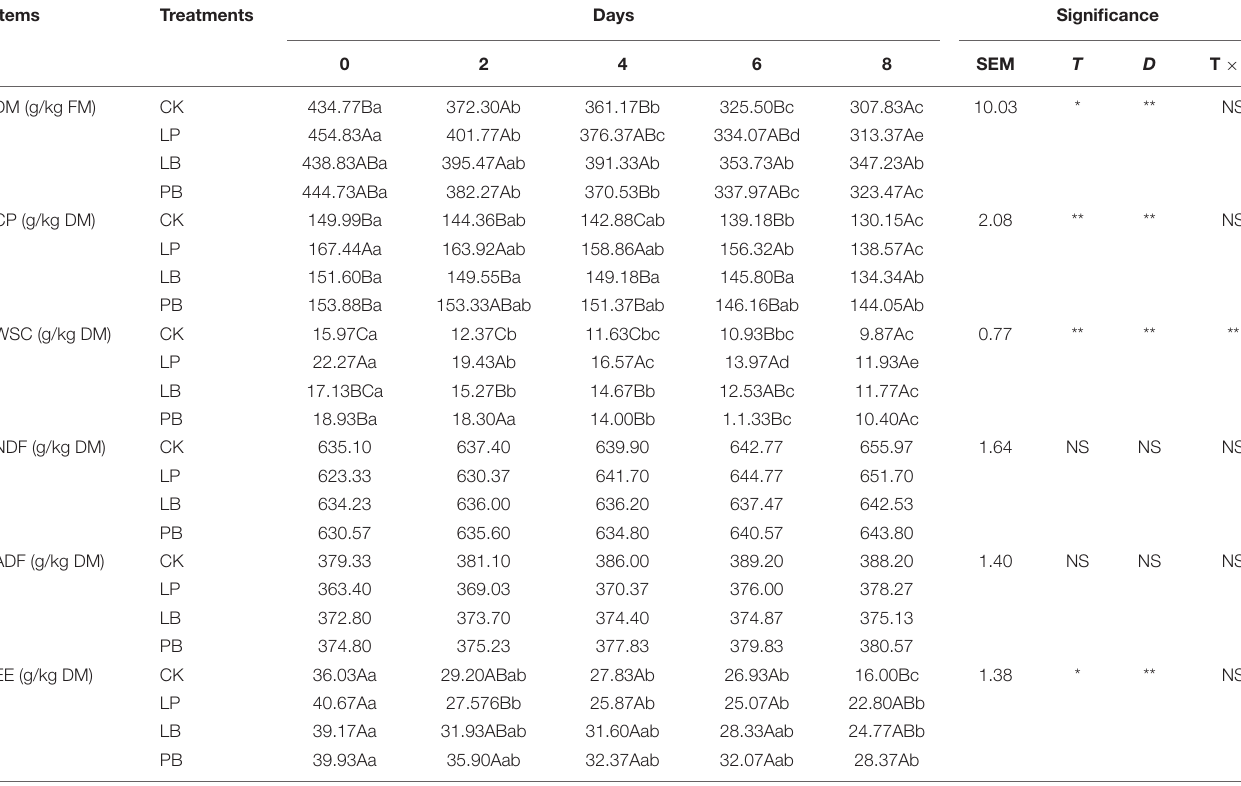
TABLE 2 | Effects of additives and days of aerobic exposure on chemical composition of Leymus chinensis silage. Items Treatments Days